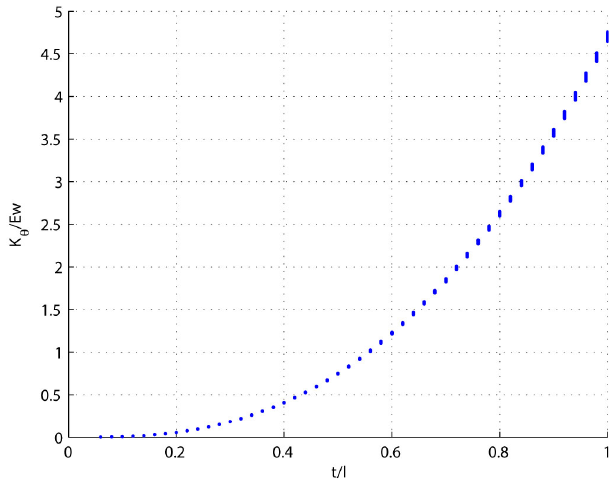
Figure 5. Rotational sti ff ness dimensionless design parameter.